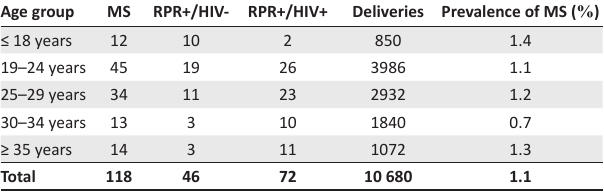
TABLE 1: Age group of mothers, maternal syphilis and human immunodeficiency virus co-infection. Age